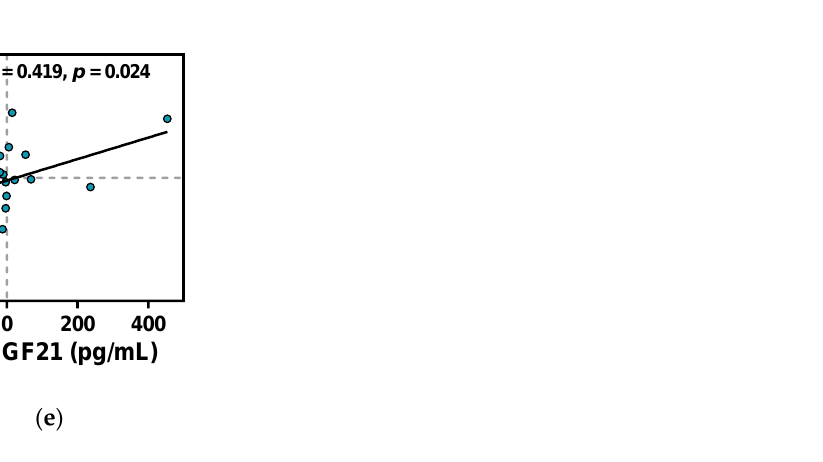
Figure 4. Correlations of ∆ FGF21 level with ( a ) ∆ glucose, ( b ) ∆ insulin, ( c ) ∆ HOMA-IR, ( d ) ∆ triglyceride, and ( e ) ∆ leptin levels before and after the intervention. Correlation coefficient (r), corresponding regression and 95% confidence interval (CI) lines, and p -values are represented in the respective panels. Blue-filled circles are individual values.